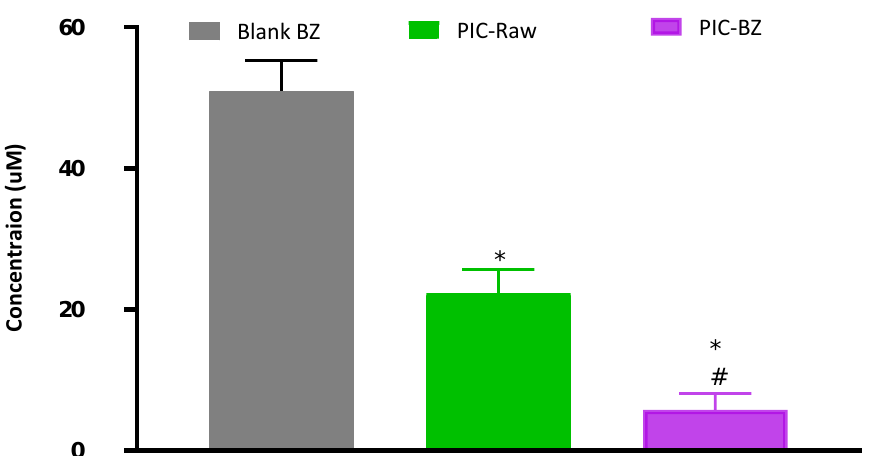
Figure 5. Cytotoxicity of PIC-BZ in A549. Cells were incubated with Blank-BZ, PIC-raw, or PIC-BZ for 48 h, and IC 50 values were determined using MTT assay. Data are the mean of 4 independent experiments ± SD. * Significantly different from Blank-PZ, p < 0.05; # significantly different from PIC-raw, p < 0.05.